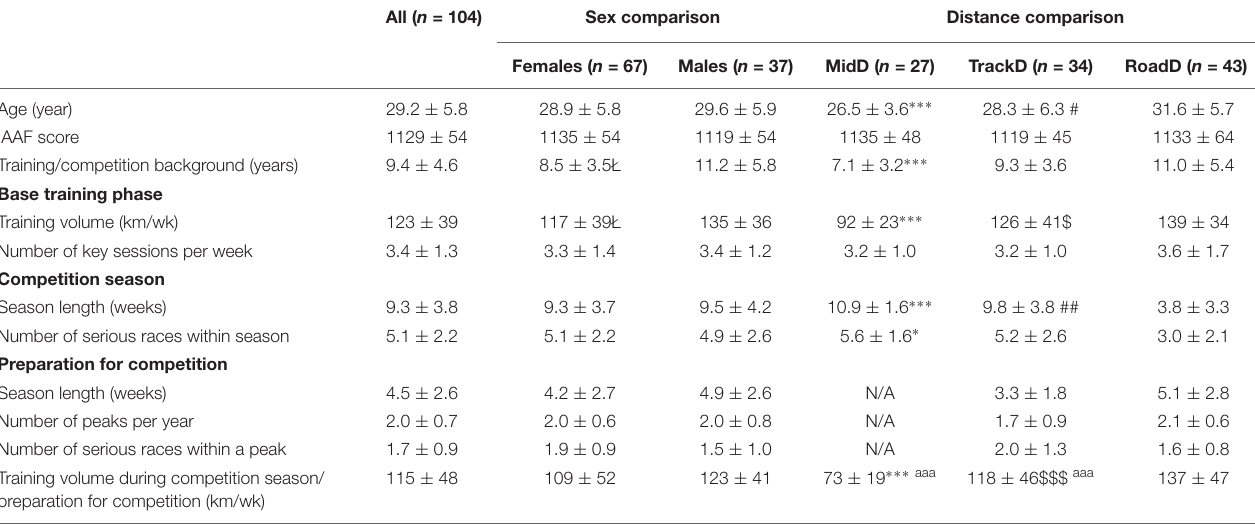
TABLE 1 | Participant background and characteristics of training and competition in elite middle/long-distance athletes (all, sex-based comparisons, distance-based comparisons). All ( n = 104) Sex